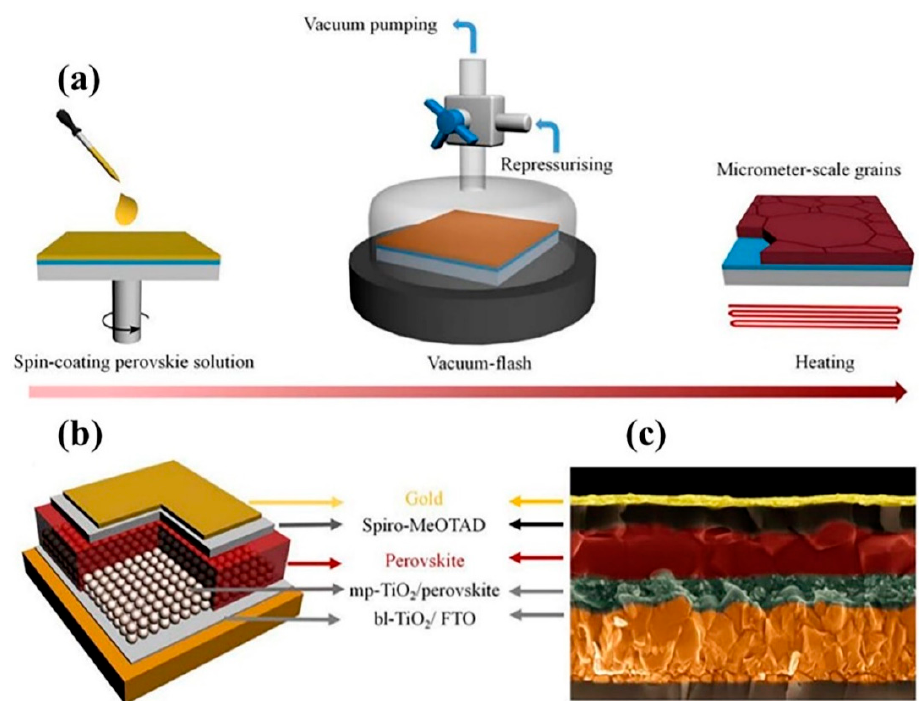
Figure 11. Perovskite film deposition and device structure. ( a ) Schematic diagram of nucleation and crystallization procedures during perovskite film formation via VASP. ( b ) Schematic diagram of the perovskite solar cell configuration, where a smooth and compact perovskite capping layer fully covers the mesoporous TiO 2 layer (mp-TiO 2 ), infiltrated with perovskite. bl-TiO 2 , TiO 2 compact layer. ( c ) A high-resolution cross-sectional SEM image of a complete solar cell fabricated by VASP [17]. Copyright 2016 American Association for the Advancement of Science.